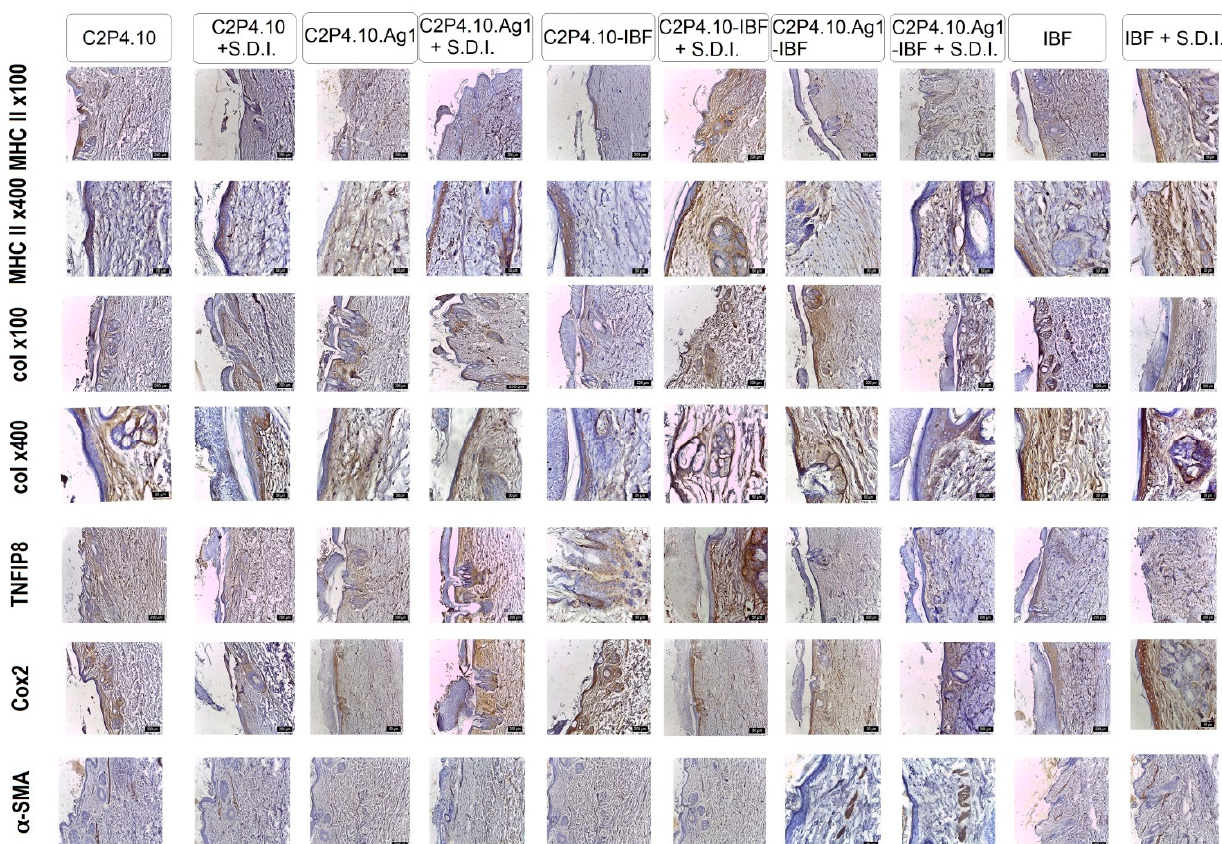
Figure 14. Col IHC of skin from rabbits from experimental and control groups, on 7th day of the experiment, exposed to different therapeutic combinations for healing with or without irritant. Col IHC with anti-CMH II, anti-Cox2, anti-TNFIP8, anti-Col I, anti-SMA.